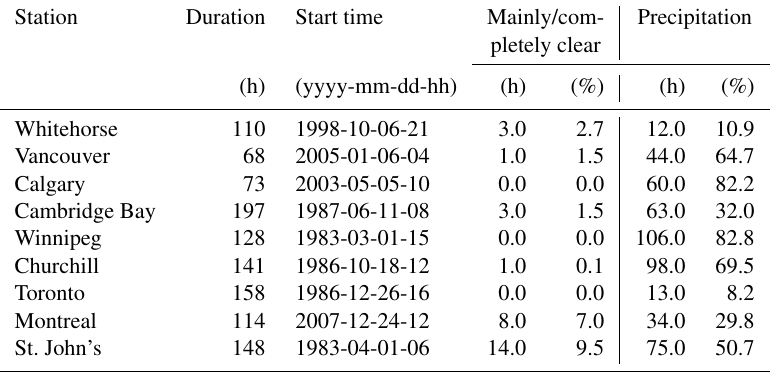
Table 5. The longest duration events at the nine selected stations. Columns indicate the maximum duration; the start time; the total hours and the fraction of the duration with mainly or completely clear sky conditions; and the total hours with any of the 12 reported precipitation types and the fraction of the duration. Times are local